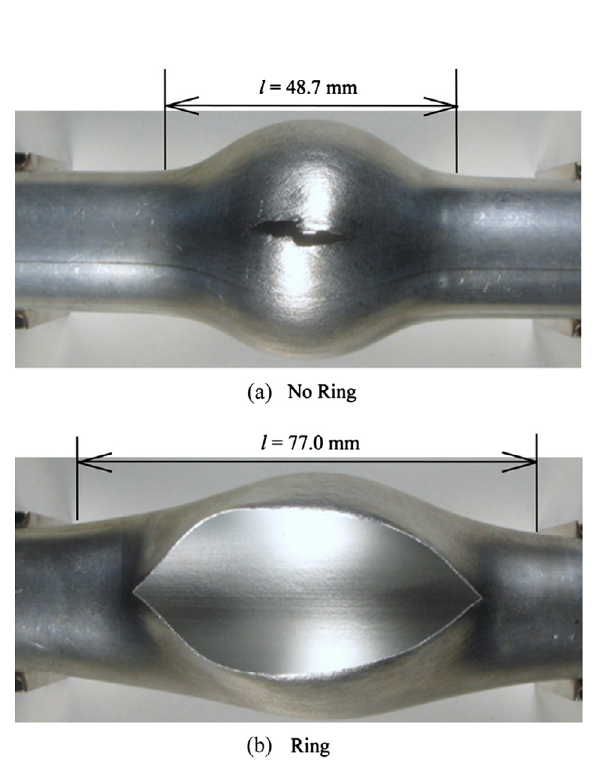
Figure 12. Burst tubes with and without stainless steel ring for J = 76 A/mm 2 and p 0 = 0.8 MPa.